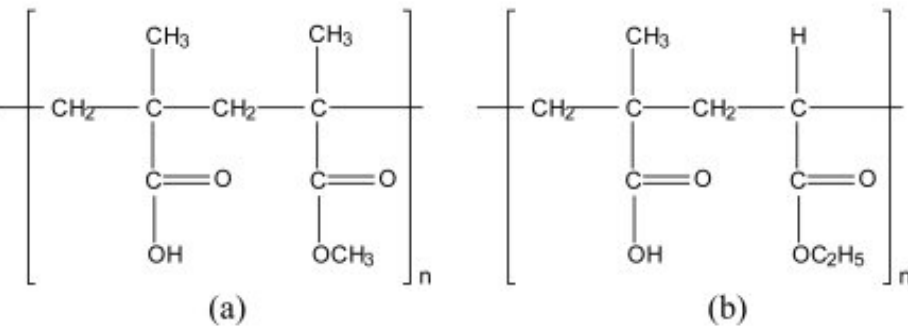
Figure 11. Represents the chemical structure of ( a ) Eudragit L 100 ( b ) Eudragit L 55 [69].